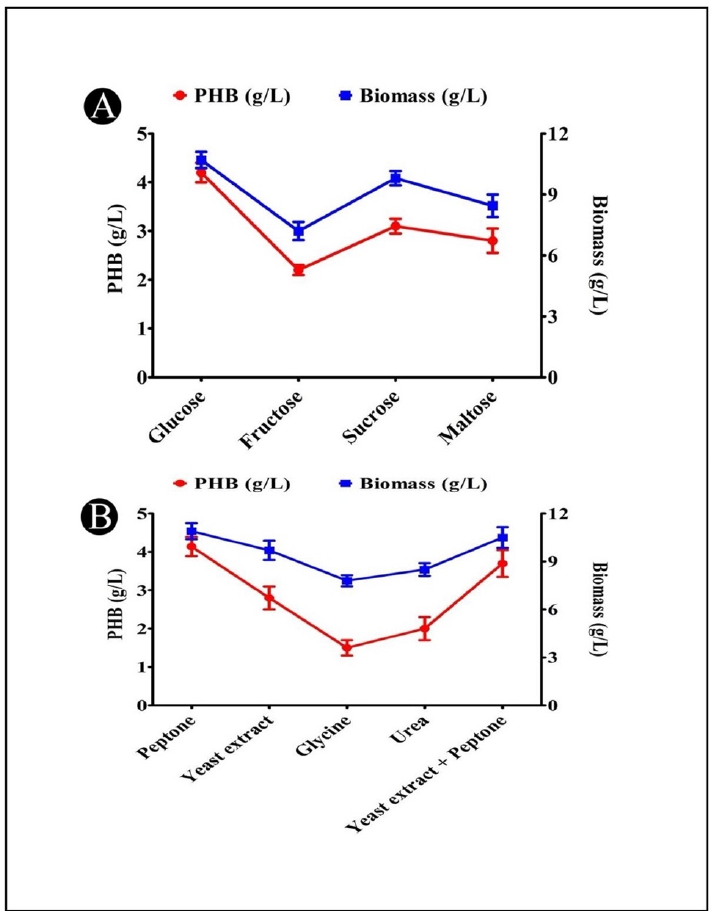
Figure 5. ( A ) Effects of different carbon sources on PHB production by A. indicus strain B2; ( B ) effects of different nitrogen sources on PHB production by A. indicus strain B2.